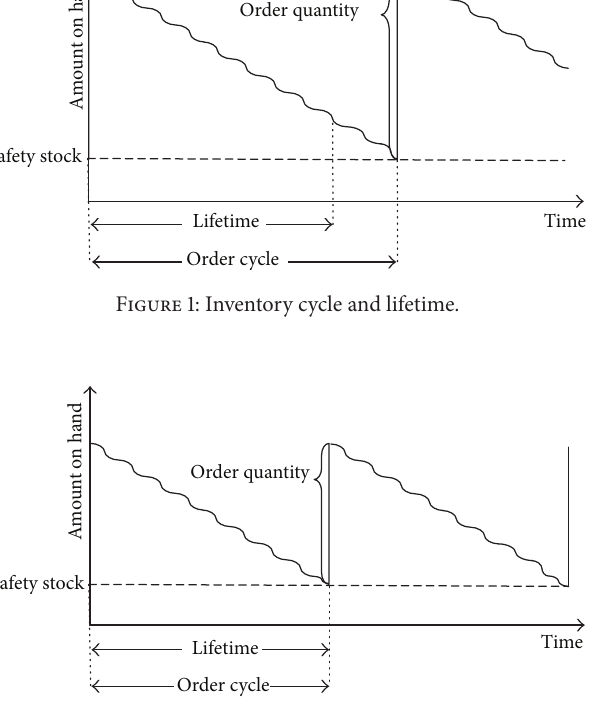
Figure 2: Inventory cycle for a perishable